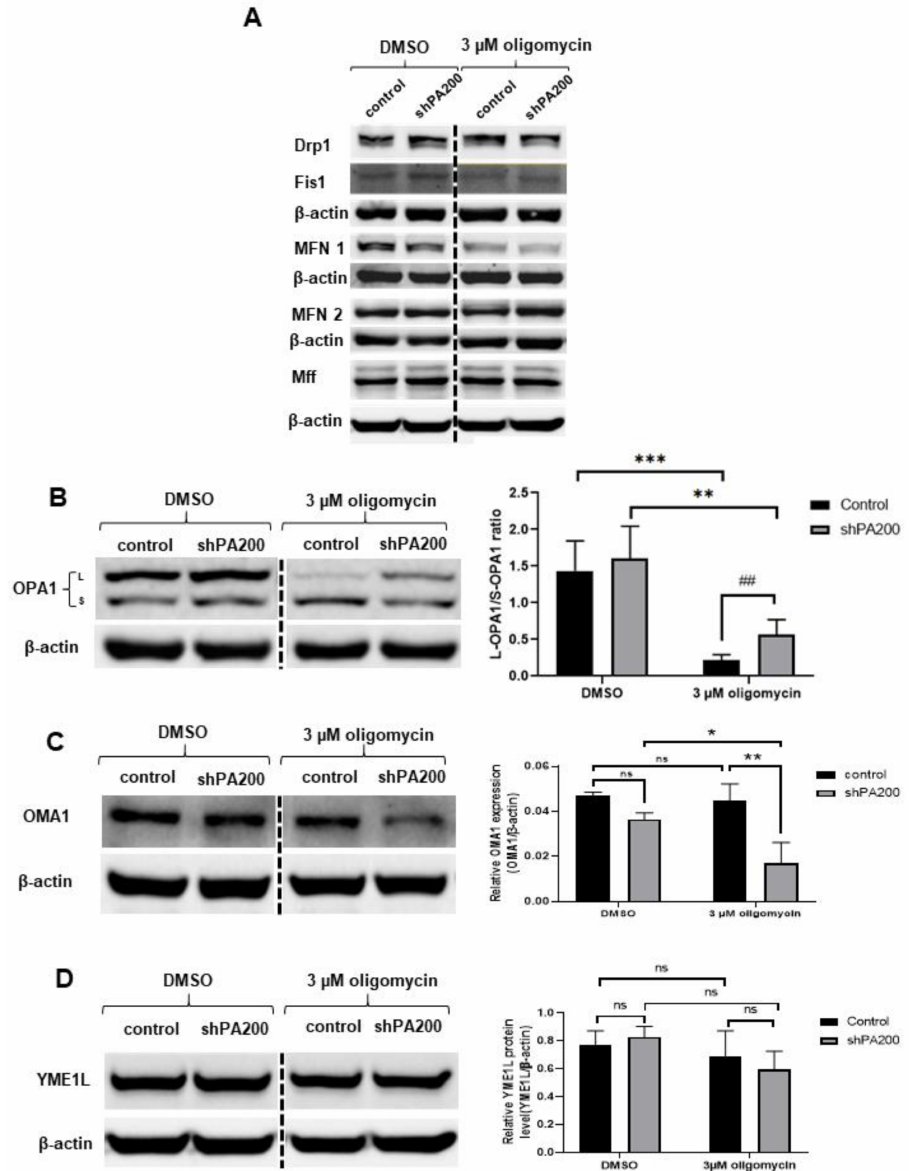
Figure 8. PA200-deficient cells exhibit low stress-induced L-OPA1 cleavage. Control and PA200-depleted cells were treated with either vehicle (DMSO) or 3 µ M oligomycin for 24 h. Cells were lysed with RIPA buffer and an equal amount of protein was separated using SDS-PAGE and analyzed by western blot. ( A ) The protein levels of mitochondrial fission and fusion proteins were examined using anti-Drp1, anti-Fis1, anti-Mfn1, anti-Mfn2, and anti-Mff antibodies. β -actin was used as an internal loading control. ( B ) Mitochondrial fusion protein levels were examined using an anti-Opa1 antibody. Representative images of western blots and statistical analysis of the relative protein levels are shown. Images were taken using a ChemiDoc imager, and the pixel intensity was quantified and normalized to the internal control, β -actin. The ratio of L-Opa1 to S-Opa1 was determined. Data are presented as mean values ± SD ( n = 4). Groups were compared using two-way ANOVA and t -tests. (** indicates p < 0.01, *** indicates p < 0.001, ## indicates p < 0.01) ( C ) IM peptidase OMA1 protein levels were examined using an anti-OMA1 antibody. Representative images of western blot and statistical analysis of the relative protein level are shown. Images were taken using a ChemiDoc imager, and the pixel intensity was quantified and normalized to the internal control, β -actin. Data are presented as mean values ± SD ( n = 4). Statistical analysis was performed using two-way ANOVA. (* indicates p < 0.05, ** indicates p < 0.01 and ns indicates not significant). ( D ) Levels of the i -AAA protease, YME1L, were examined using an anti-YME1L antibody. Representative images of western blots and statistical analysis of the relative protein level are shown. Images were taken using a ChemiDoc imager, and the pixel intensity was quantified and normalized to the internal control, β -actin. Data are presented as mean values ± SD ( n = 4). Groups were compared using two-way ANOVA. (ns indicates not